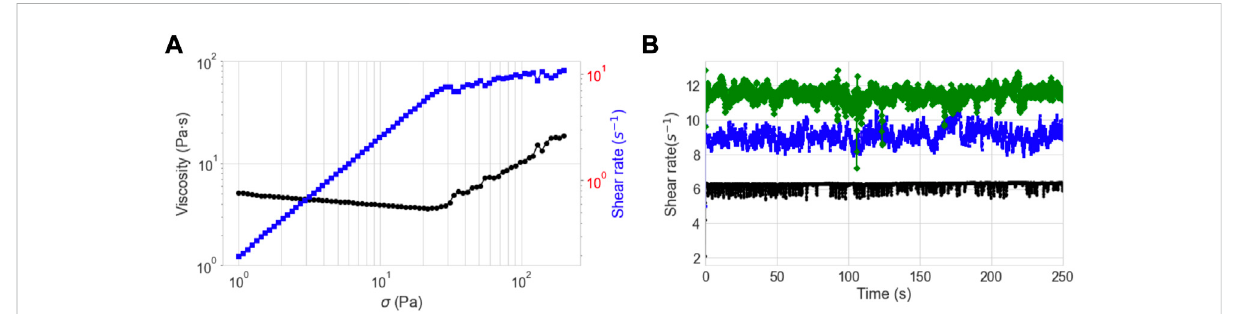
FIGURE 5 Representative space-time kymographs generated from linescans (vertical) stacked horizontally at 20 Pa constant applied stress at heights of 3 μ m (top), 10 μ m (middle), and 20 μ m above the bottom surface. Each image consists of 4,096 scans, for an elapsed time of 520 ms (Note that the orientation is different than Figure 2, with time on the horizontal